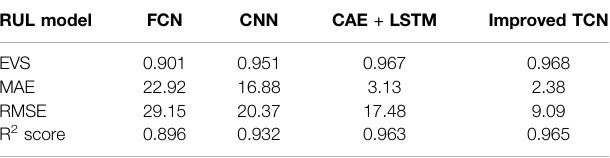
TABLE 5 | Average test losses of different RUL prediction